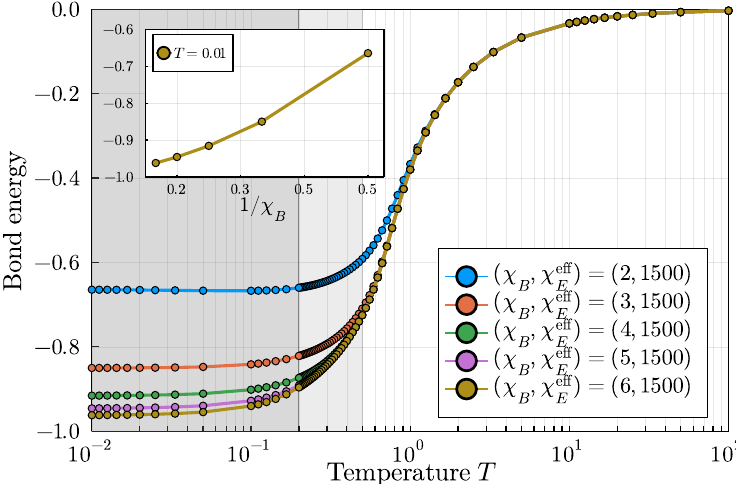
· ˆ S 〉 on horizontal and vertical nearest-neighbour links. Figure 6: Bond energy −〈 ˆ S i j The inset shows the convergence of the bond energy vs. the inverse bulk bond di- mension at T = 0.01. As T → 0, the relative weights of all angular momenta in Eq. (24) tend to become equal, so that the only sensible scaling indeed seems to be against the (inverse) number of the allowed